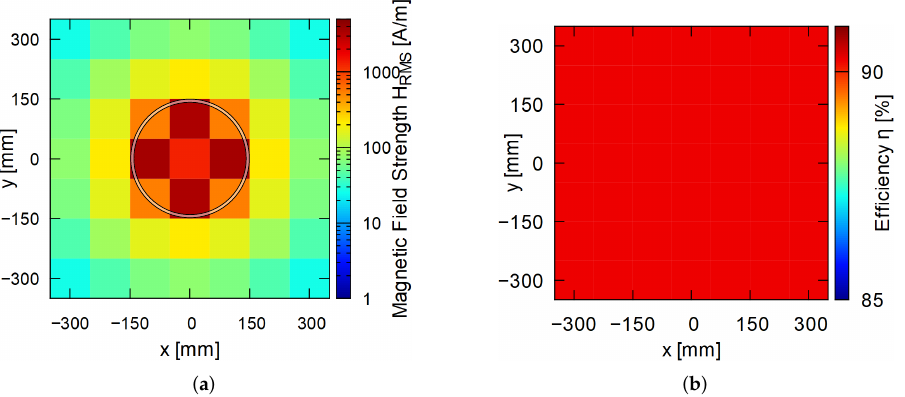
Figure 10. Color map (1 Tx): ( a ) transmission (Tx) coil configuration and magnetic field strength map and ( b ) transmission efficiency map. At the evaluation point (center of each cell), with the decrease in the magnetic field strength H RMS , the blue shading in the cell becomes darker and, with the increase in the power transmission efficiency η , the red shading in the cell becomes